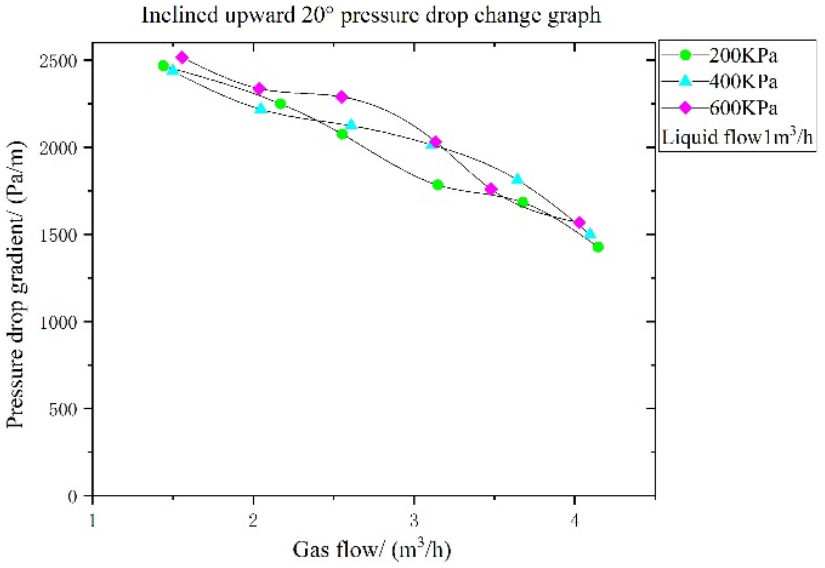
Figure 16. Pressure gradient diagram at different pressures and gas flow rates at 20° upward tilt.